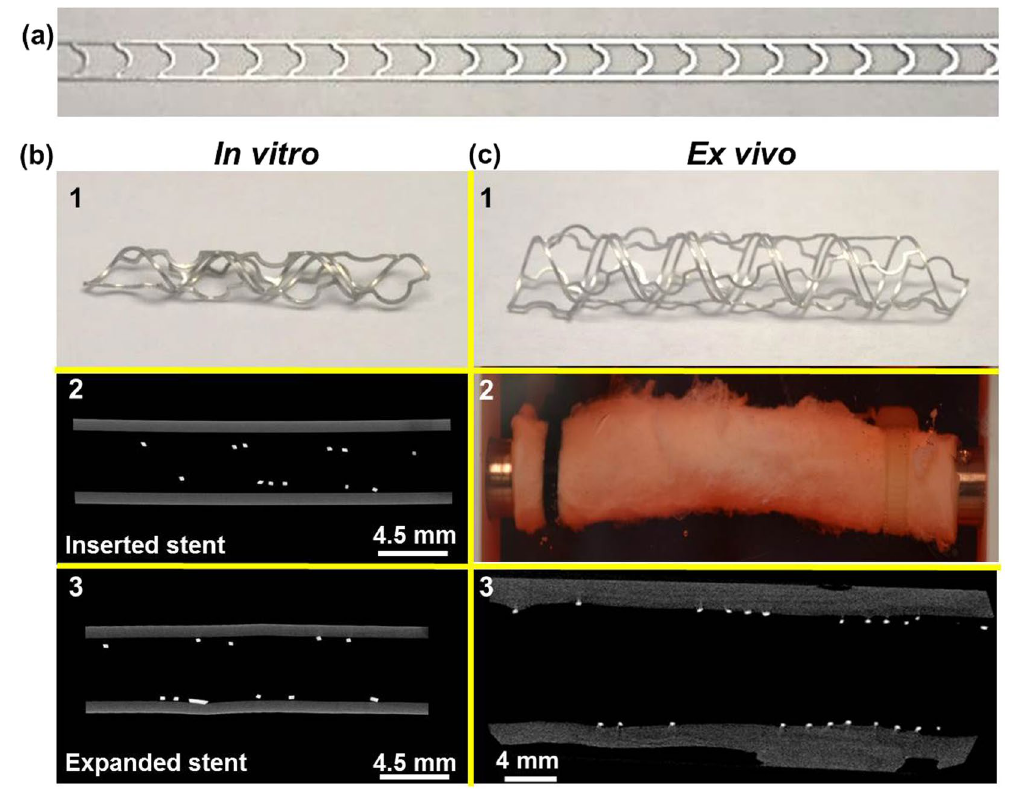
Figure 3. Geometries and stenting of Mg-based helical stent for vascular bioreactor tests. ( a ) Optical image of 2D Mg-based ribbon before coiling to form the device, ( b ) In vitro stent testing: optical image of helical stent for in vitro test (b1), inserted stent in artificial vessel (b2), and expanded stent in vessel (b3), ( c ) Ex vivo stent testing: optical image of helical stent for ex vivo (c1), optical image of the inserted stent in porcine artery (c2), and expanded stent in artery